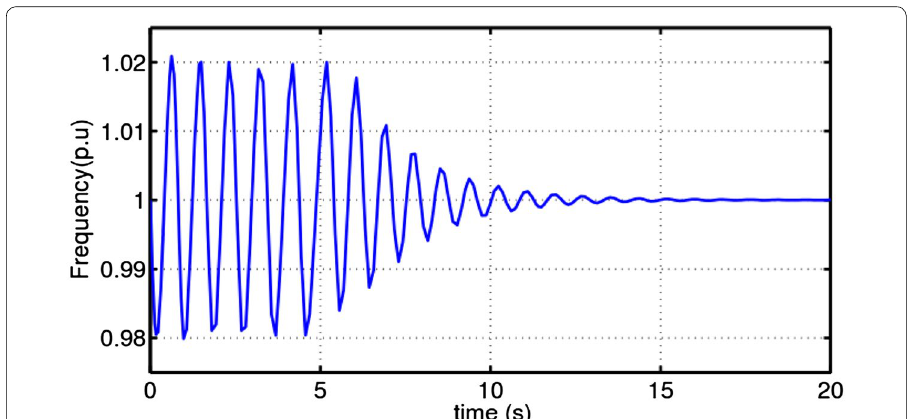
Fig. 13 Frequency of microgrid system with ζ